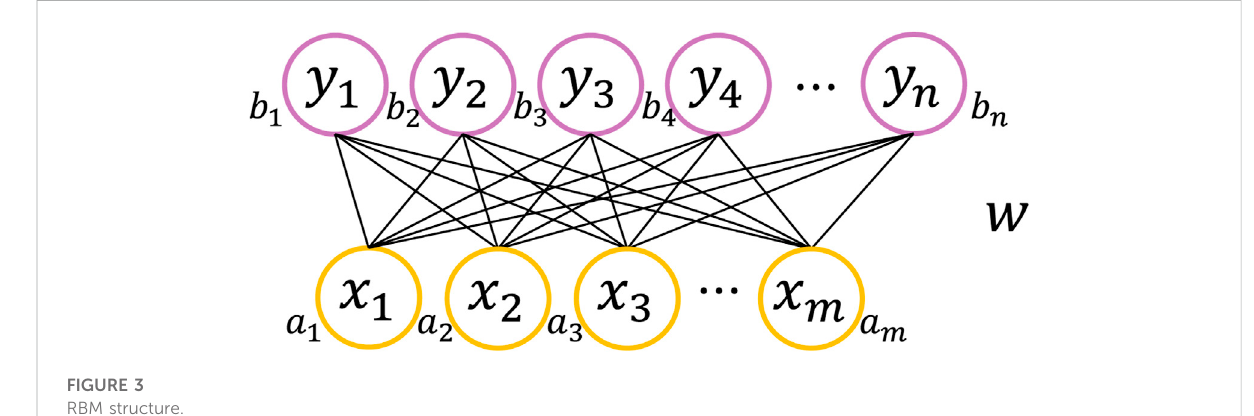
FIGURE 3 RBM structure.